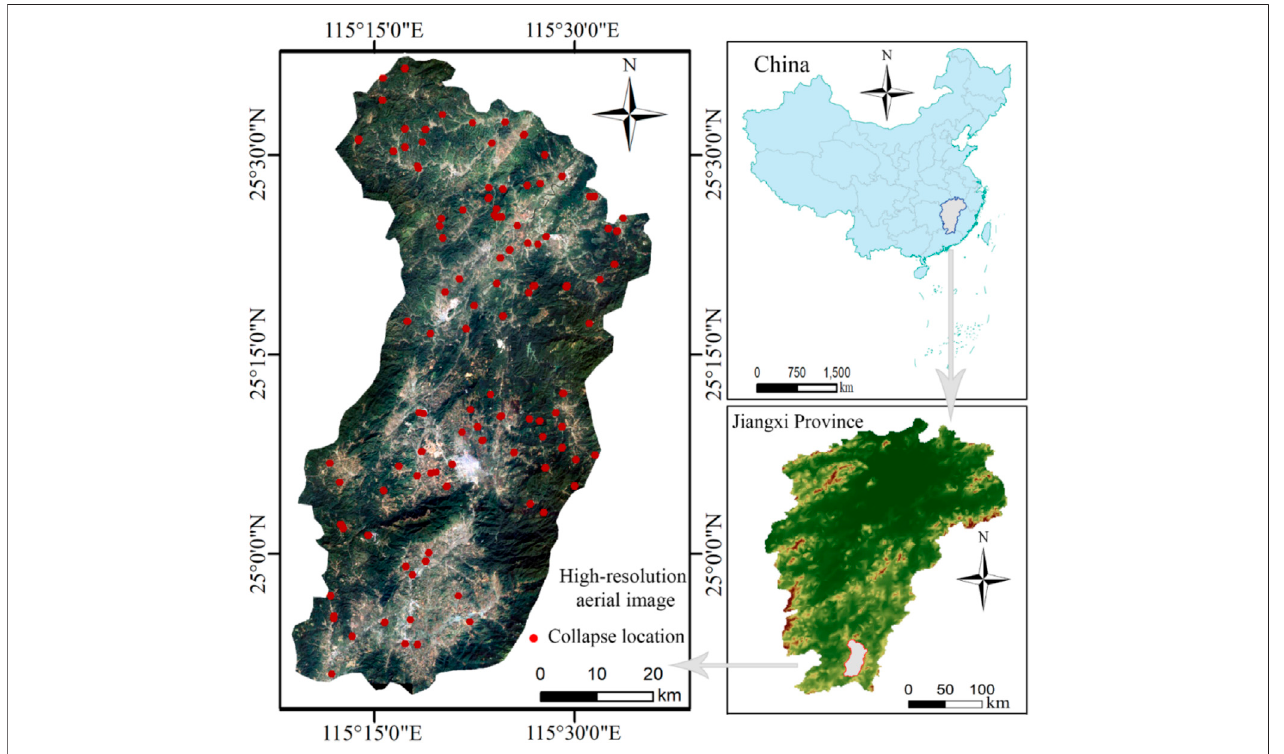
FIGURE 2 | Geographical location and collapse